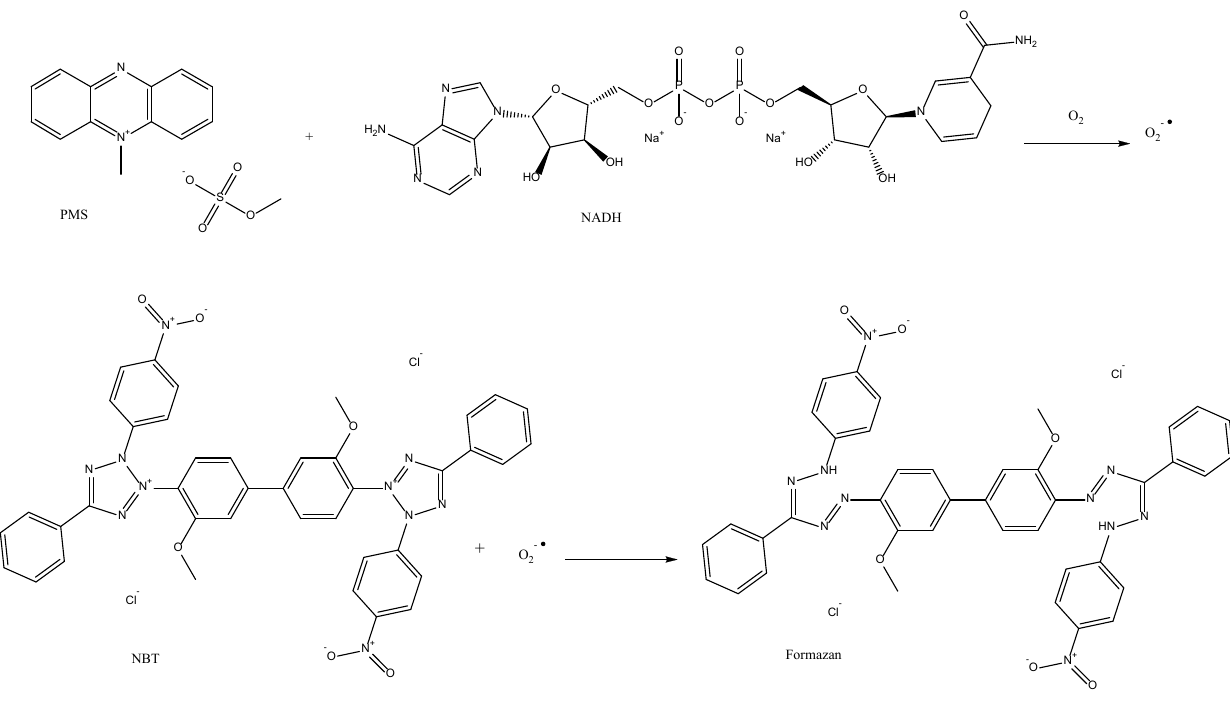
Figure 17. NBT mechanism reacting with superoxide radicals [58].